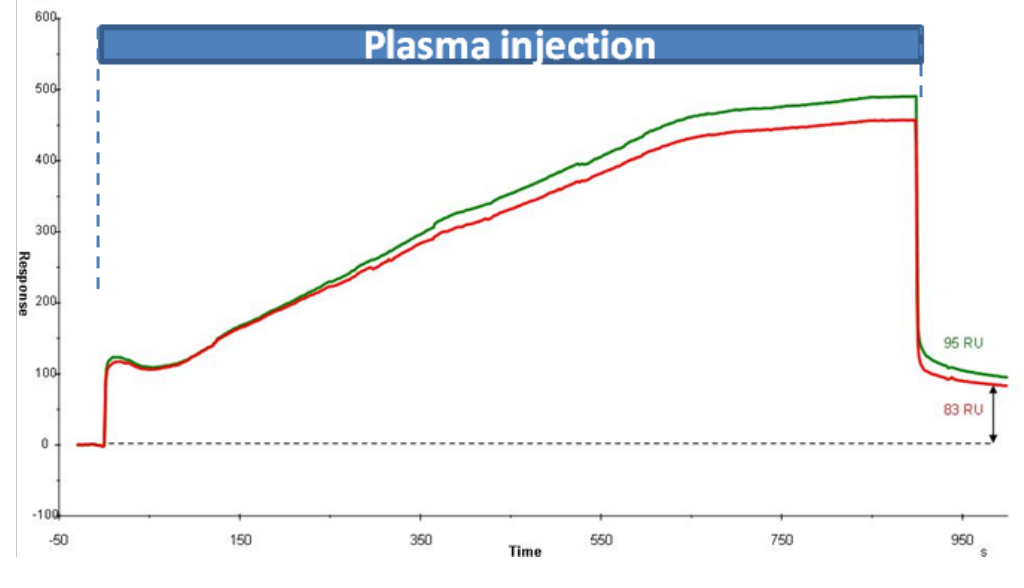
Figure 1. Sensorgram of the response of diluted human plasma (2.5%) onto immunochips, especially α-LAG3 (green curve) and α-RSA (red curve) at 25 °C, during 15 min at a flow rate of 20